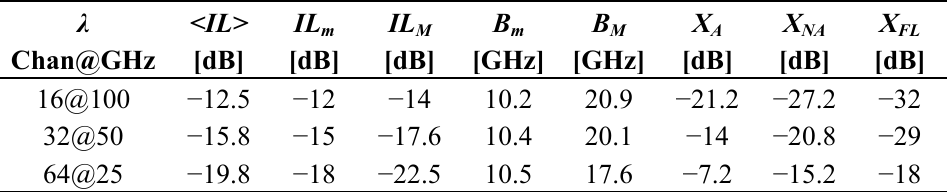
Table 1. Increasing channels at fixed spectrum.